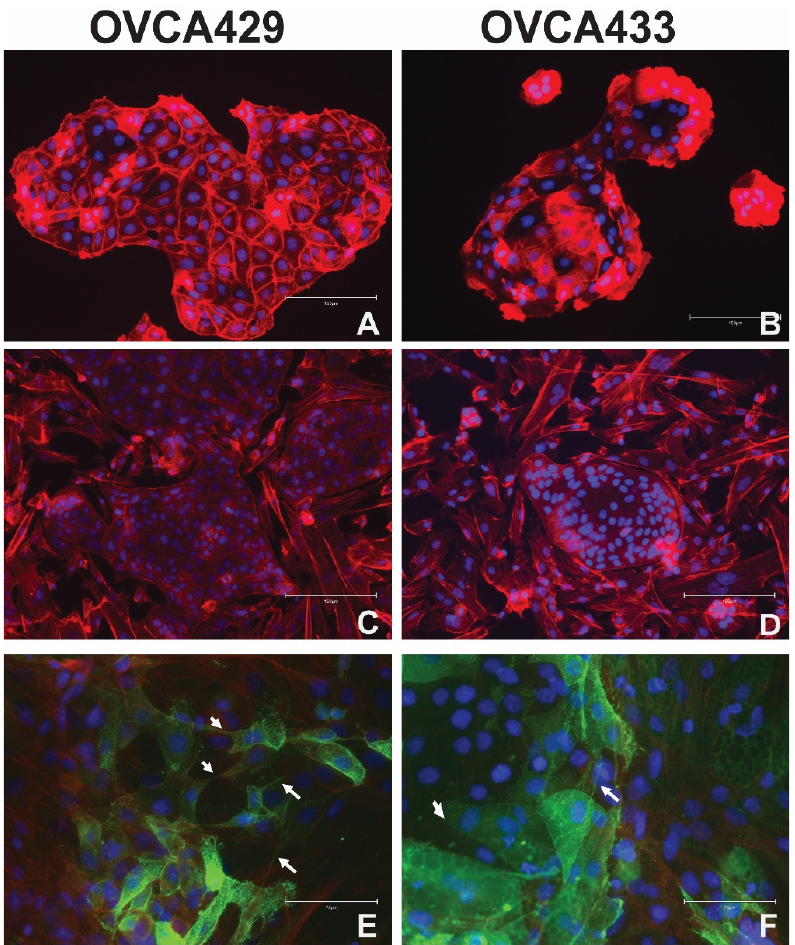
Figure 1. Morphology of ovarian cancer cells when co-cultured with mesothelial cells and omental adipocytes. Panels A and B depict the normal cobblestone epithelial morphology of OVCA429 ( A ) and OVCA 433 ( B ) cells when stained with Texas Red Phalloidin for F-actin (and DAPI for nuclei). OVCA429 ( C ) and OVCA433 ( D ) cells were cultured on top of a confluent layer of primary human mesothelial cells and stained with Texas Red phalloidin after 24 h. OVCA429-CD133-GFP ( E ) and OVCA433 CD133-GFP ( F ) cells were cultured on top of confluent differentiated omental adipocytes for 5 days. 40X original magnification. Scale bar = 75 µm. Green = GFP/adipocytes. Arrow = tumor cell projections.